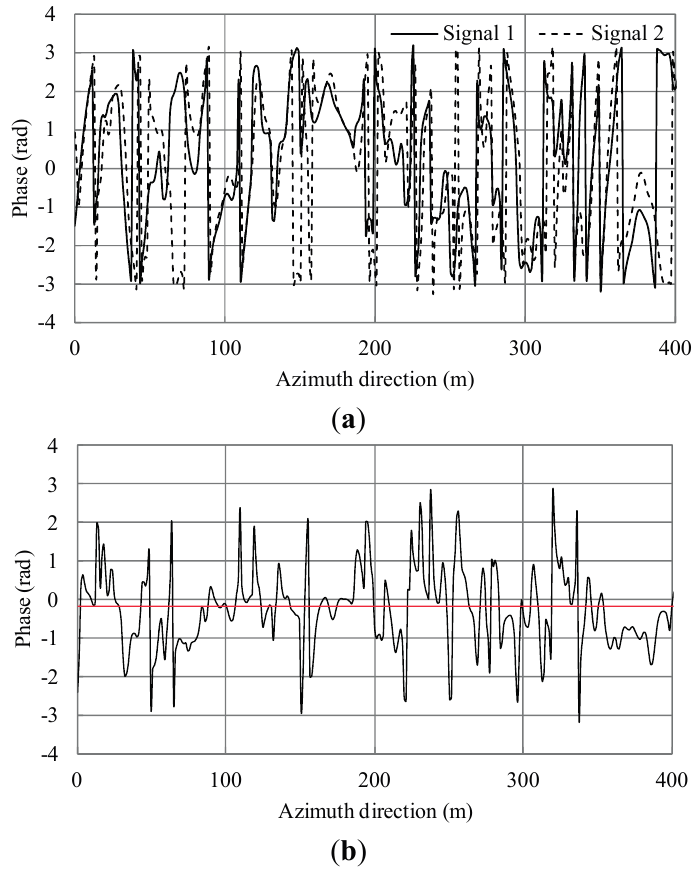
Figure 12. Simulation results of additional current and irregular waves for wind speed 15 m/s. ( a ) Phase of simulated SAR signals of master and slave antennas in the azimuth direction. ( b ) Phase differences of (a). The black line shows the phase differences. The red line shows the